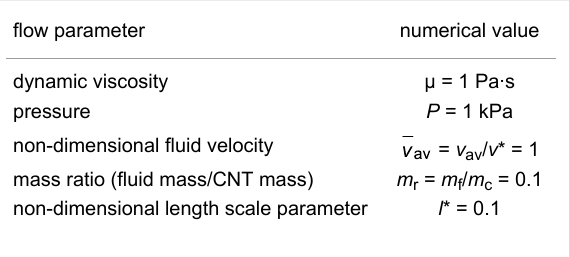
Table 1: Viscous fluid flow parameters of Figure